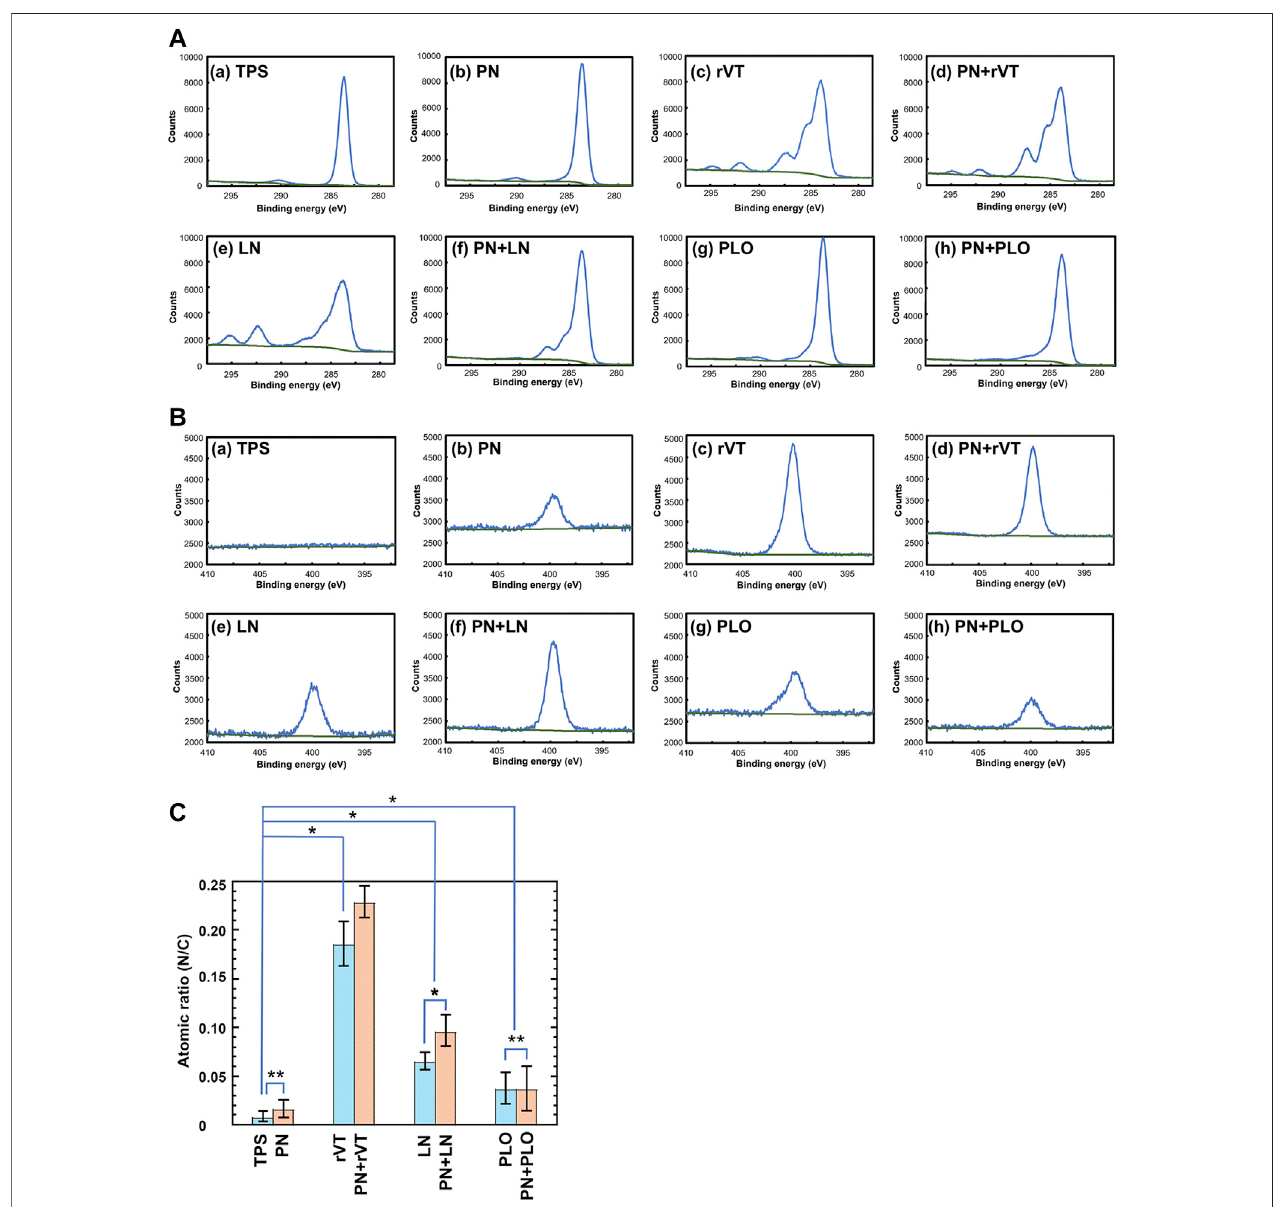
FIGURE2| CharacterizationofTPS,TPS-PN,TPS-ECM,TPS-PLO,TPS-PN-ECMandTPS-PN-PLOplates. (A) High-resolutionXPSspectraoftheC1speakson the surface of TPS (a) , TPS-PN (b) , TPS-rVT (c) , TPS-PN-rVT (d) , TPS-LN (e) , TPS-PN-LN (f) , TPS-PLO (g) and TPS-PN-PLO (h) plates. (B) High-resolution XPS spectra of the N1s peaks on the surface of TPS (a) , TPS-PN (b) , TPS-rVT (c) , TPS-PN-rVT (d) , TPS-LN (e) , TPS-PN-LN (f) , TPS-PLO (g) and TPS-PN-PLO (h) plates. (C) Thenitrogentocarbon(N/C)atomicratiosonthesurfaceofTPS,TPS-PN,TPS-ECM,TPS-PLO,TPS-PN-ECMandTPS-PN-PLOplates.* p < 0.05.** p > 0.05.